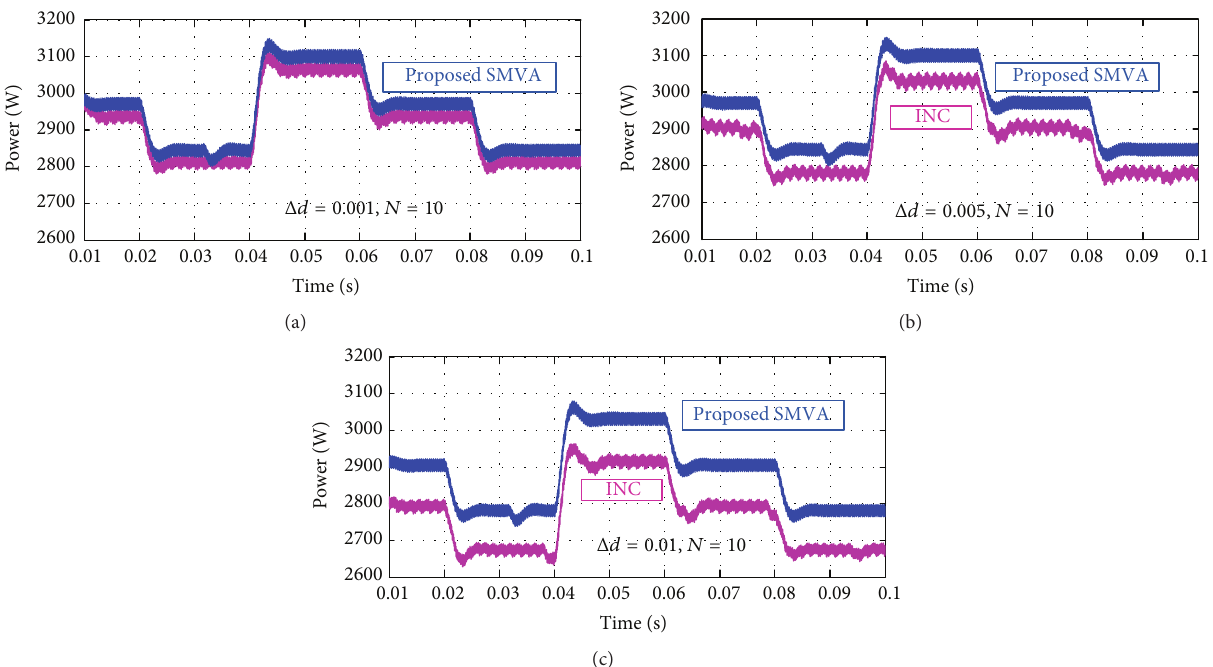
Figure 13: Output power comparison with Δ𝑑 = 0.001 , 0.005, and 0.01 and 𝑁 = 10